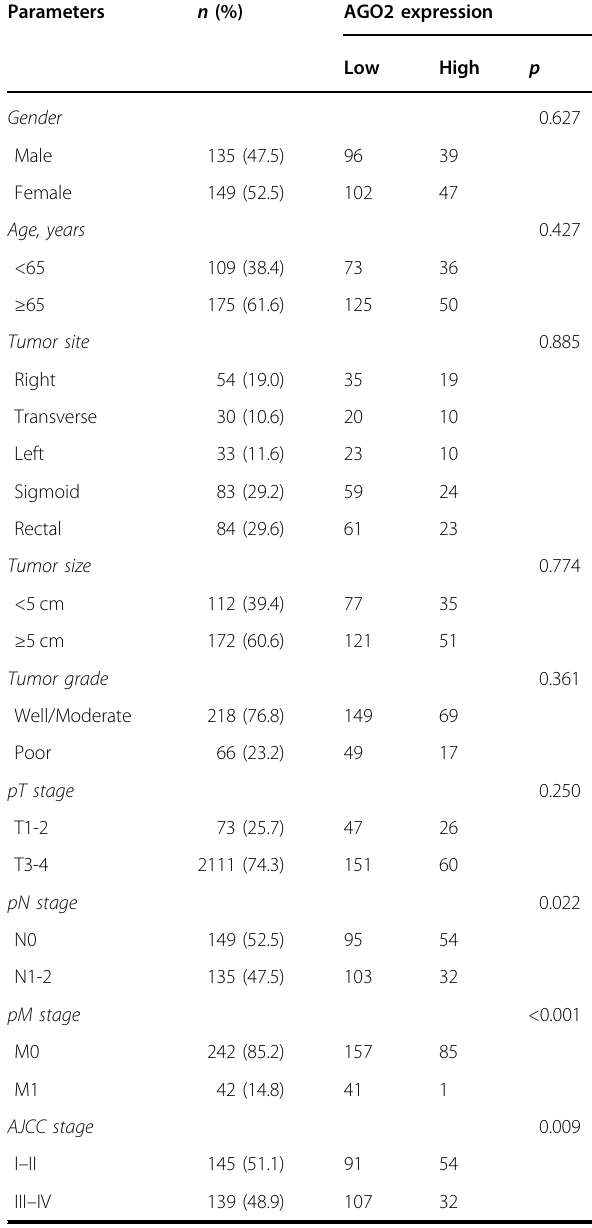
Table 1 Relationship between clinical features and AGO2 protein expression in 284 colorectal cancer